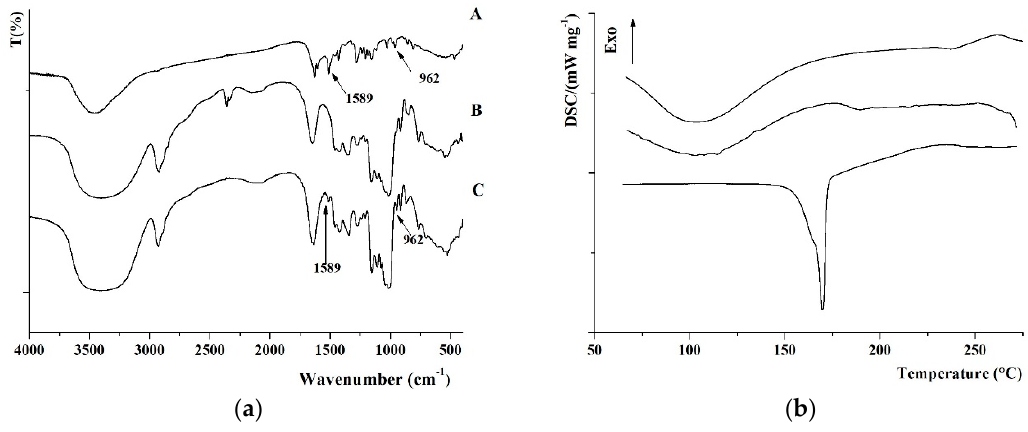
Figure 1. ( a ) FT-IR spectra and ( b ) DSC thermograms of CUR (A), DEX (B), and DEX-CUR (C).